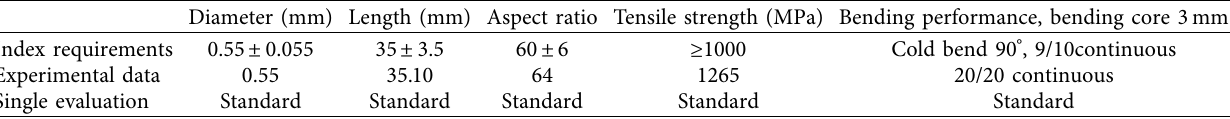
Table 4: Steel fiber